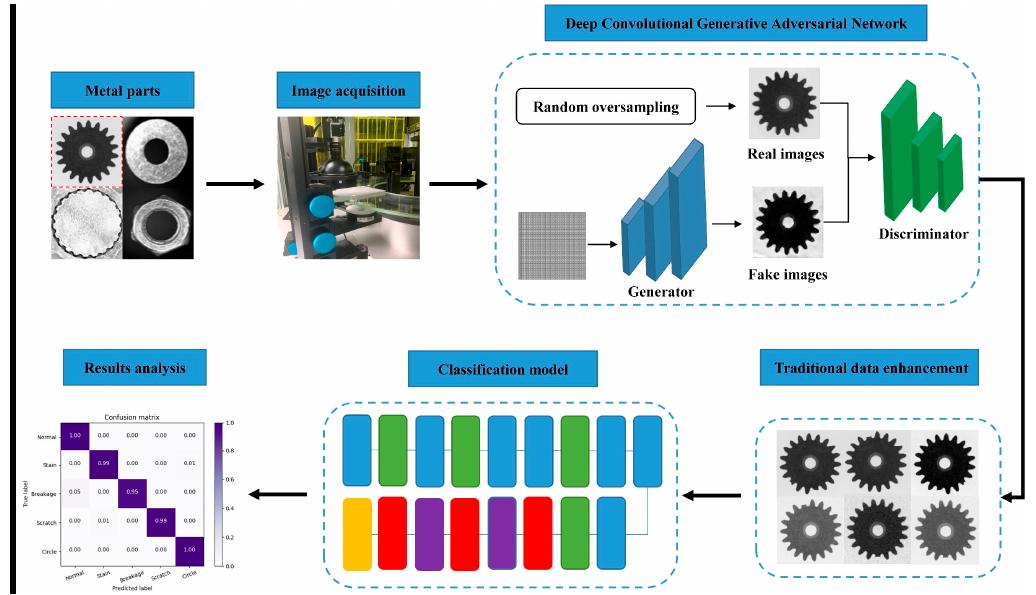
Figure 2. Flow chart of the overall experiment procedures proposed.